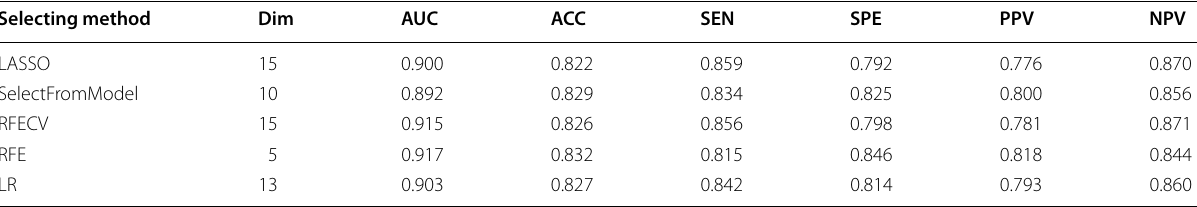
LASSO, Least Absolute Shrinkage and Selection Operator; RFECV, Recursive Feature Elimination Cross Validation; RFE, Recursive Feature Elimination; LR, Logistic Regression; Dim, dimension; AUC, area under the receiver operator characteristic curve; ACC, accuracy; SEN, sensitivity; SPE, specificity; PPV, positive predictive value; NPV, negative predictive value